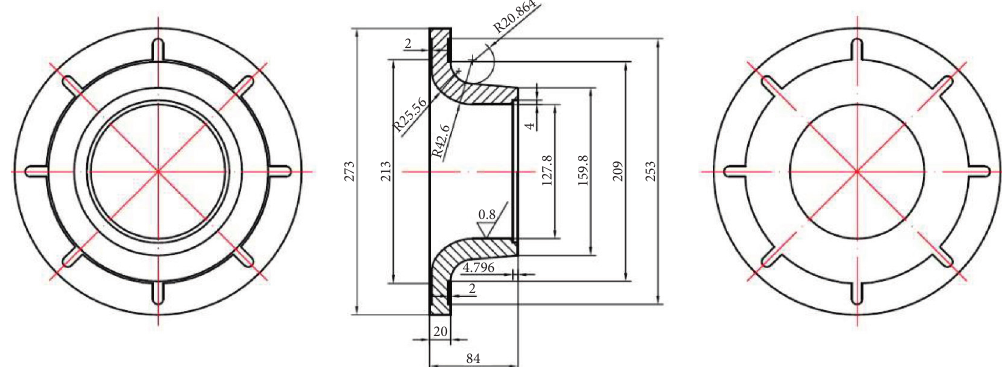
Figure 3: Eight-slot